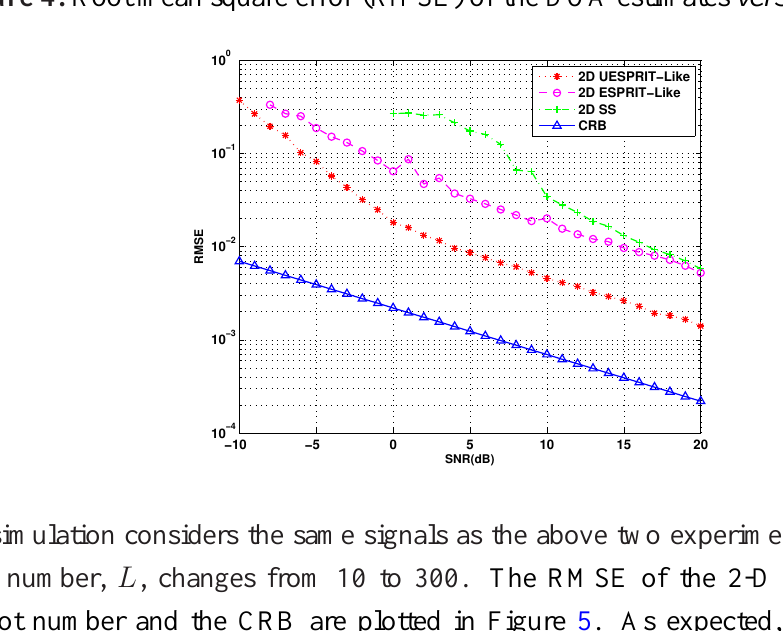
Figure 4. Root mean square error (RMSE) of the DOA estimates versus input SNR.